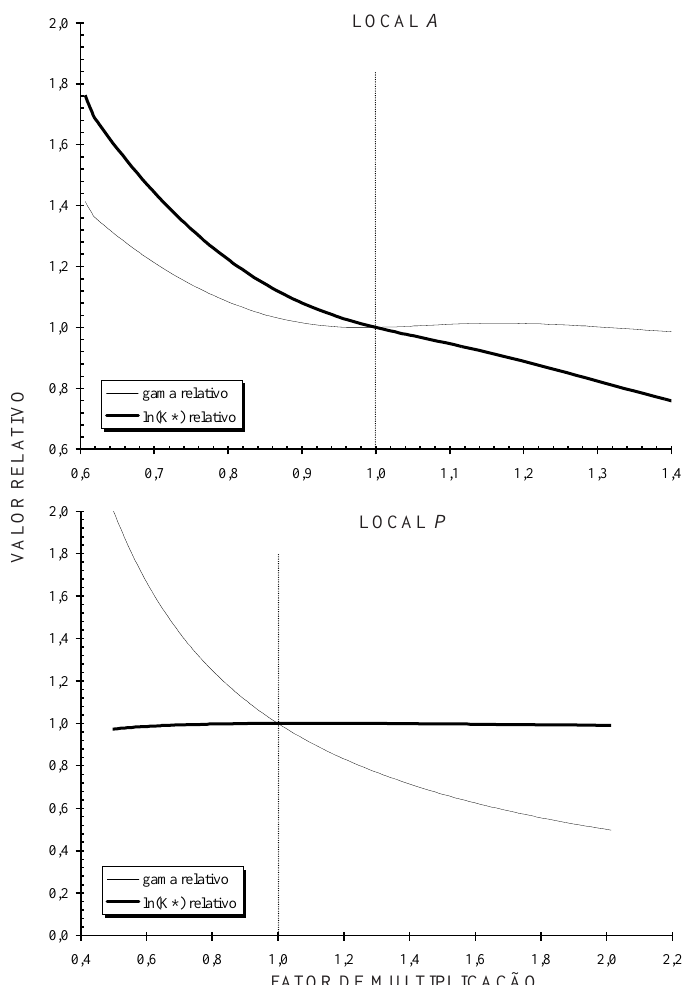
Figura 6. Valores de ggggg e ln(K * ) para o local A (0,20 m) e local P (0,30-0,45 m), obtidos da indução de um erro nos coeficientes angulares de calibração do TDR de todas as profundidades, multiplicando-os pelo fator na abscissa, relativos, respectivamente, aos valores de ggggg de